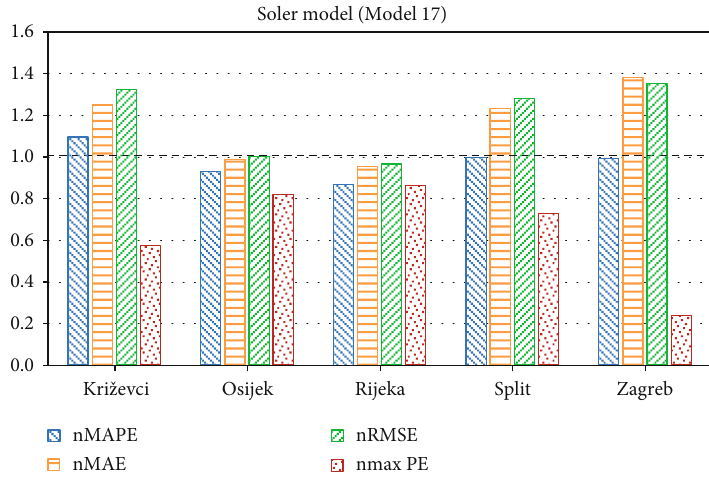
Figure 8: Comparison of statistical parameters (MAPE, MAE, RMSE, and max PE) for the Soler model based on the data from fi ve stations (Kri ž evci, Osijek, Rijeka, Split, and Zagreb). All parameters are shown as relative values adjusted to the original